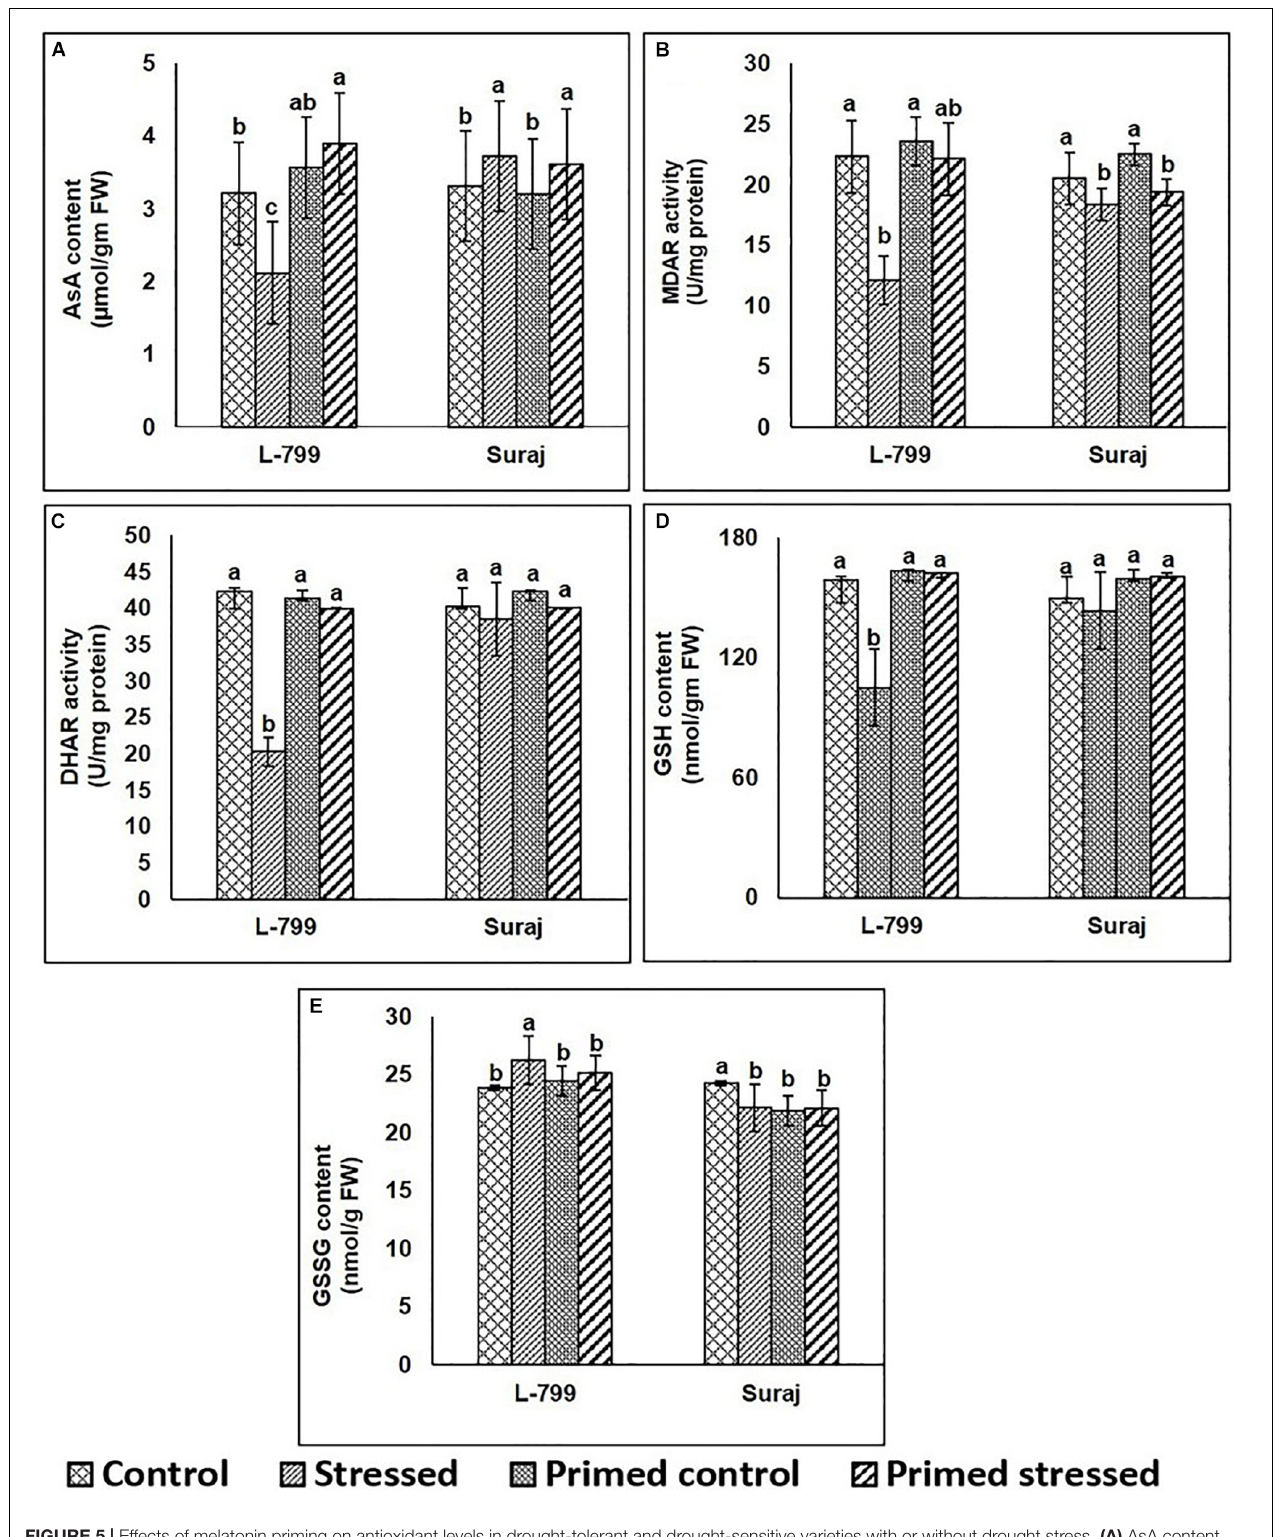
FIGURE 5 | Effects of melatonin priming on antioxidant levels in drought-tolerant and drought-sensitive varieties with or without drought stress. (A) AsA content, (B) MDAR activity, (C) DHAR activity, (D) GSH, and (E) GSSG contents in leaves of melatonin primed and unprimed L-799 and Suraj varieties after exposure to drought stress or optimal conditions. Data represent mean values ± SD of minimum 3 independent experiments. Different alphabets within the group represent significant differences among treatments according to Duncan multiple range test at P < 0.05.